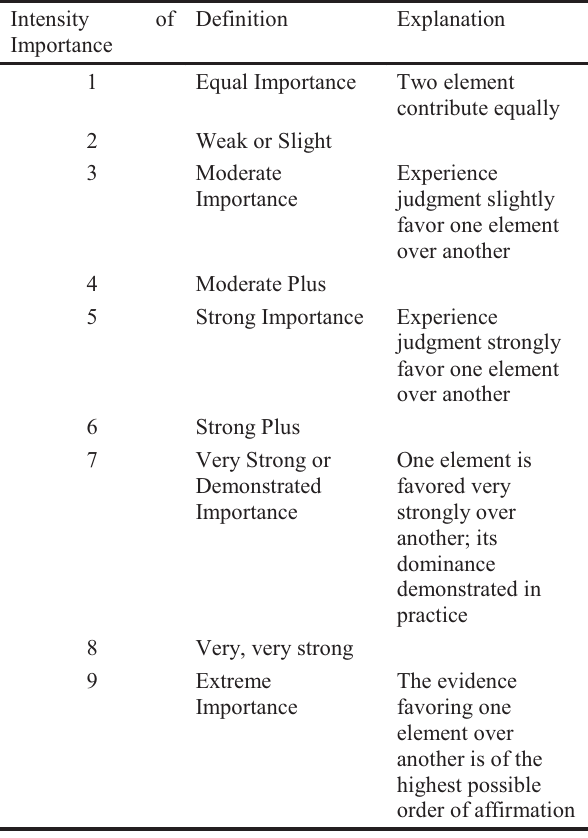
Table 1. Fundamental scale for ANP.